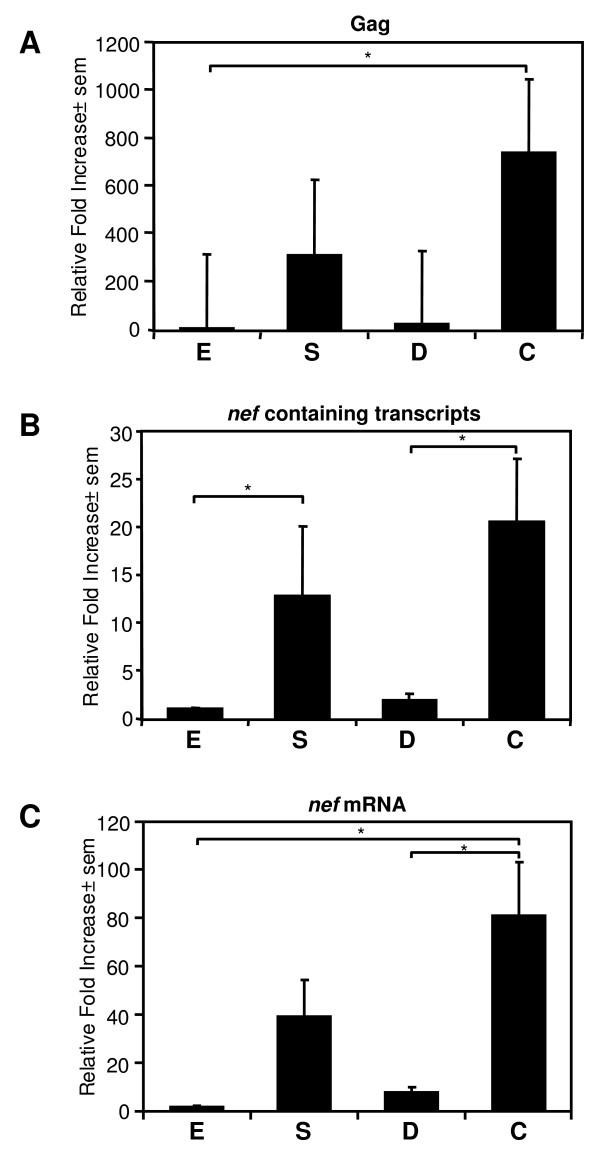
Real-time RT-PCR analysis of viral expression in gut tissues. (A) Real-time RT-PCR analysis of gag gene expression levels (viral genomic RNA normalized against GAPDH mRNA levels) in the esophagus (E), stomach (S), duodenum (D) and colorectum (C) tissue of HIV-1 infected individuals. Increased viral gag gene (viral genomic transcripts) expression in the colorectal tissues compared to the esophagus were observed. All gag expression levels were expressed relative to the gag expression levels in the esophagus (* = p < 0.05, Dunn's multiple comparison test). Real-time RT-PCR analysis of all viral RNAs (genomic as well as viral mRNA transcripts) containing the Nef protein open reading frame (B) and nef gene specific mRNA expression levels (C) (normalized against GAPDH mRNA levels) in the esophagus (E), stomach (S), duodenum (D) and colorectum (C) tissue of HIV-1 infected individuals. Differing RNA expression levels with increased viral nef gene expression in the colorectal tissues were observed. Again all RNA expression levels were expressed relative to the RNA expression levels in the esophagus (* = p < 0.05, Dunn's multiple comparison test).